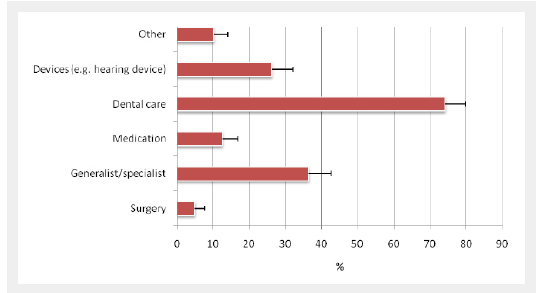
Type of renounced health care during the previous 12 months among a representative sample of 35 to 74 year old citizens of the canton of Geneva, Switzerland (2008-9).